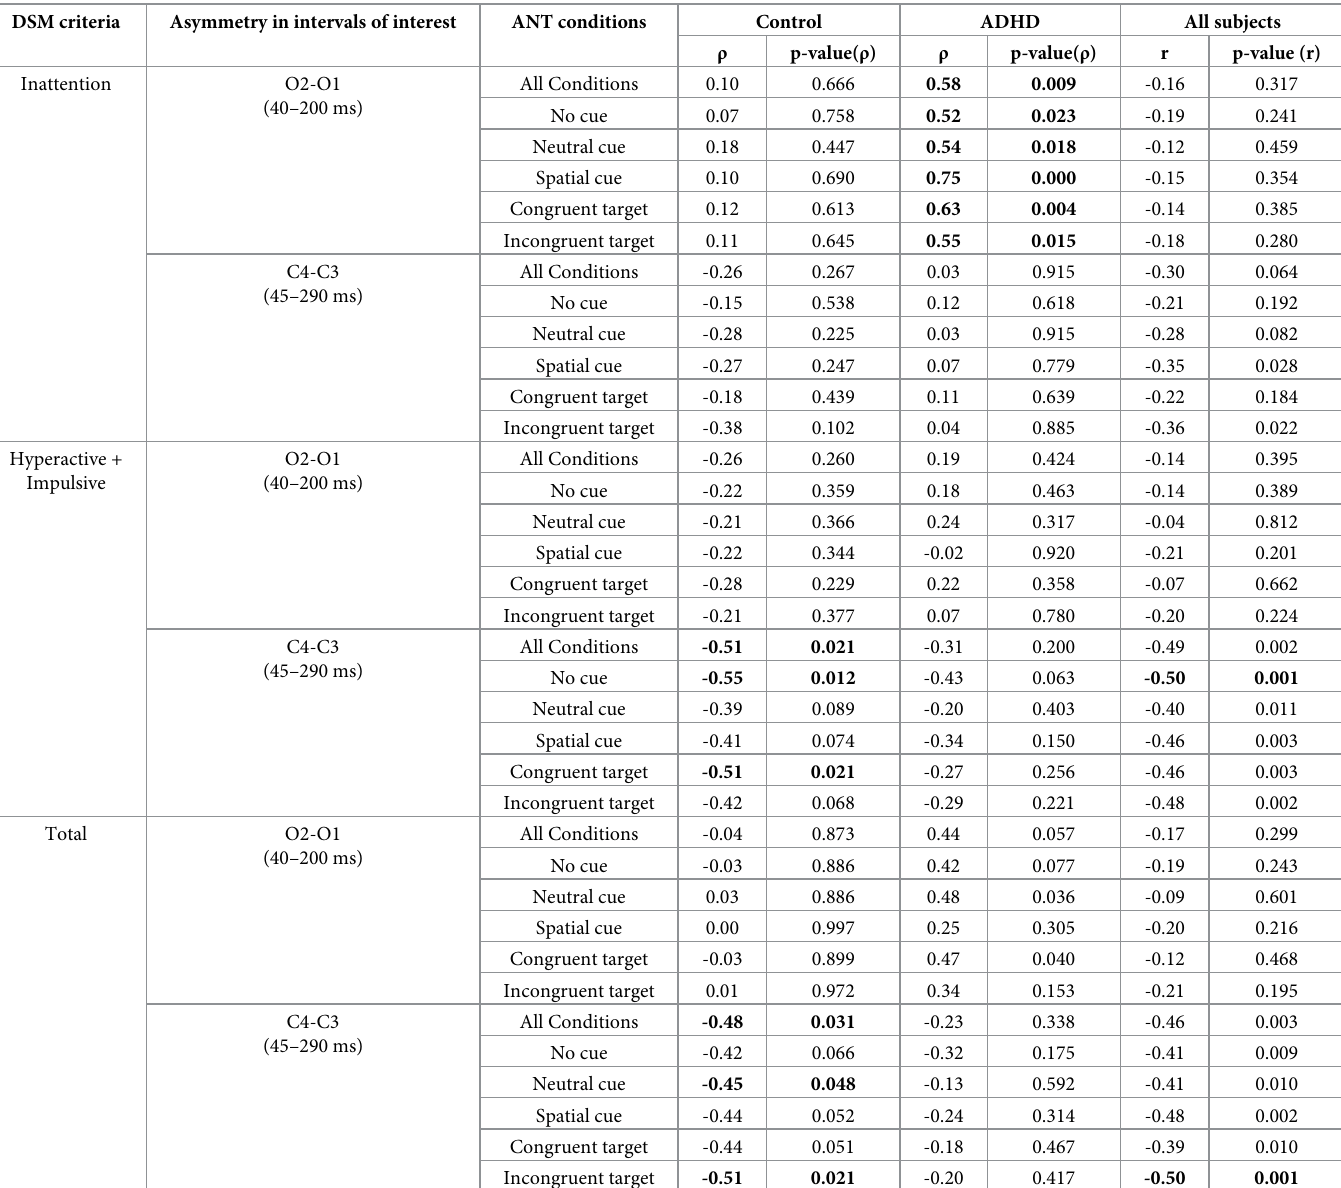
Table 5. Correlations between asymmetries (mean amplitude) in occipital and central regions of different ANT conditions and DSM scores. DSM criteria